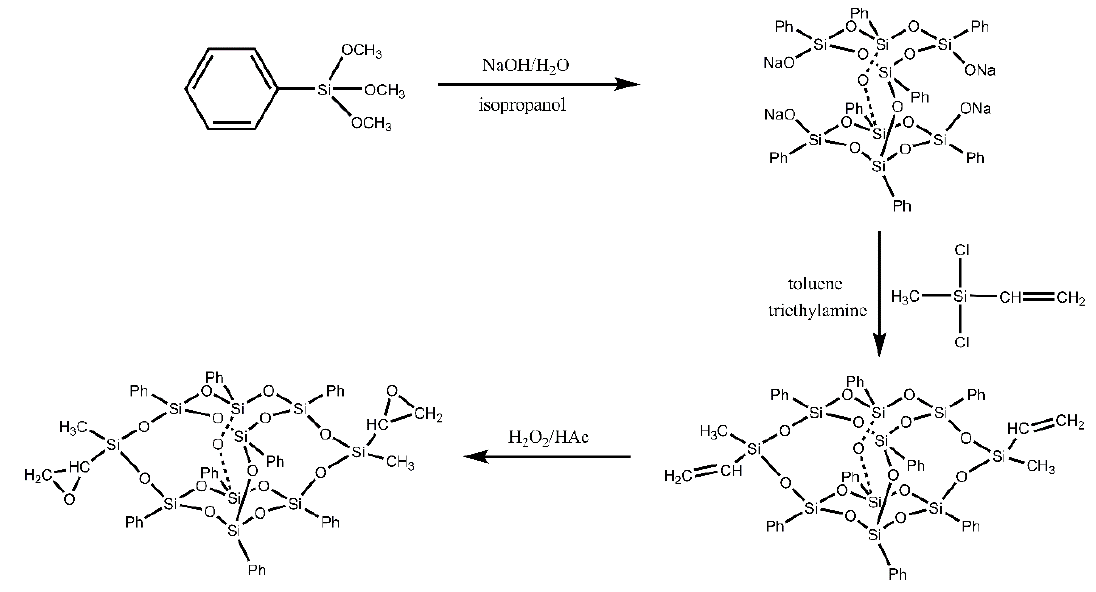
Figure 2. Synthetic route of DDSQ-EP.